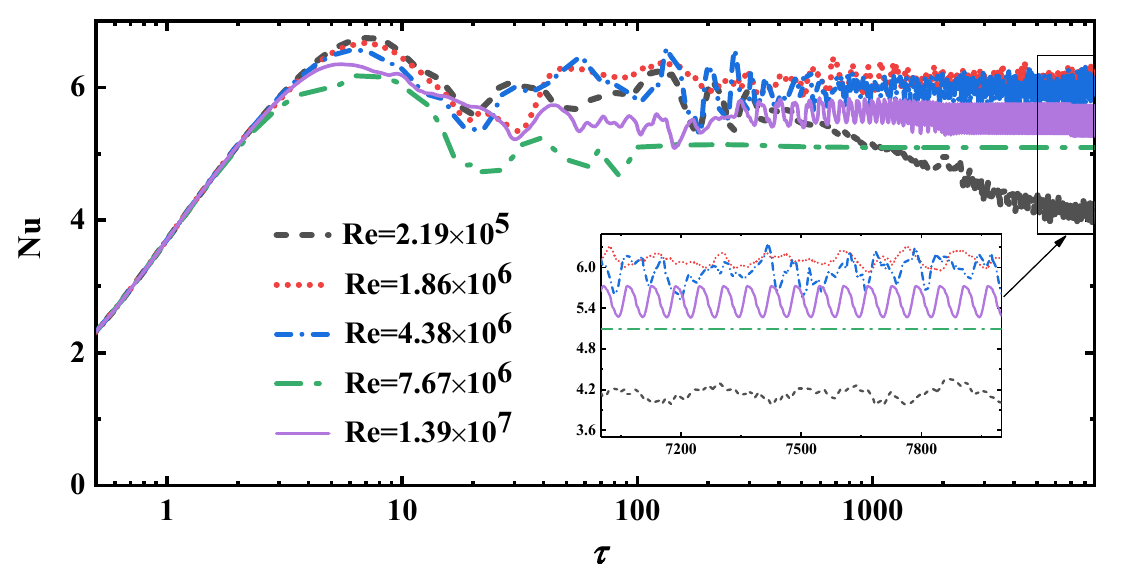
Figure 3. The time development series of averaged Nu on the heated wall in the fully developed stage.